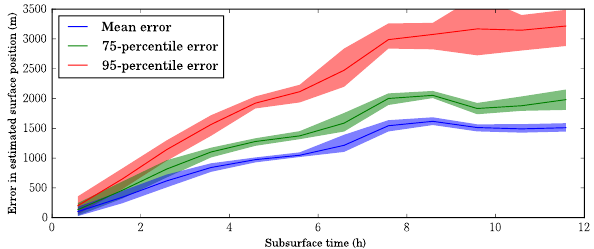
Figure 8. Error in estimated resurfacing position as a function of subsurface